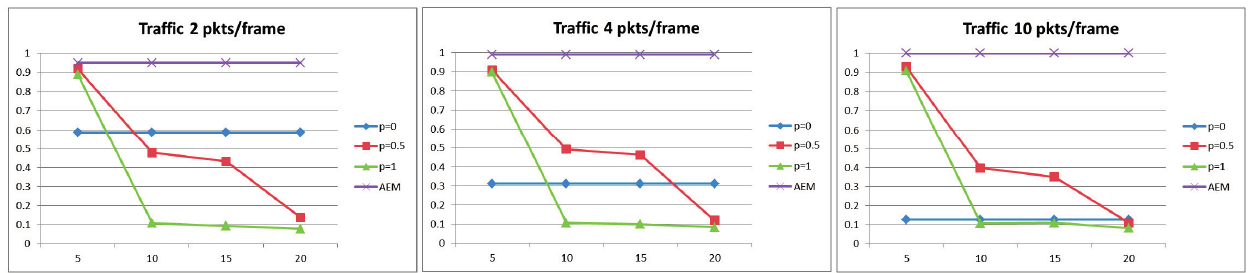
Figure 3. Probability of successful delivery for D = 20 s.